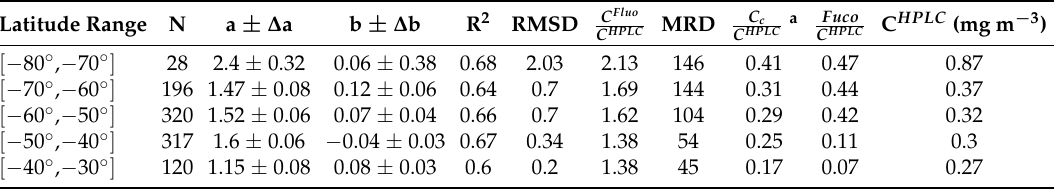
Table 5. Statistics of the relationship between chlorophyll-a measured from HPLC and fluorometry for different ranges of latitude, the proportion of chlorophyll-c and Fucoxanthin is also indicated. The number of observations (N), the slope (a), the intercept (b) and their standard deviations ( ∆ a and ∆ b) and the coefficient of determination (R 2 ) of the linear regression are indicated. RMSD is the root mean square difference and MRD is the mean relative difference (see Section 2.3 for